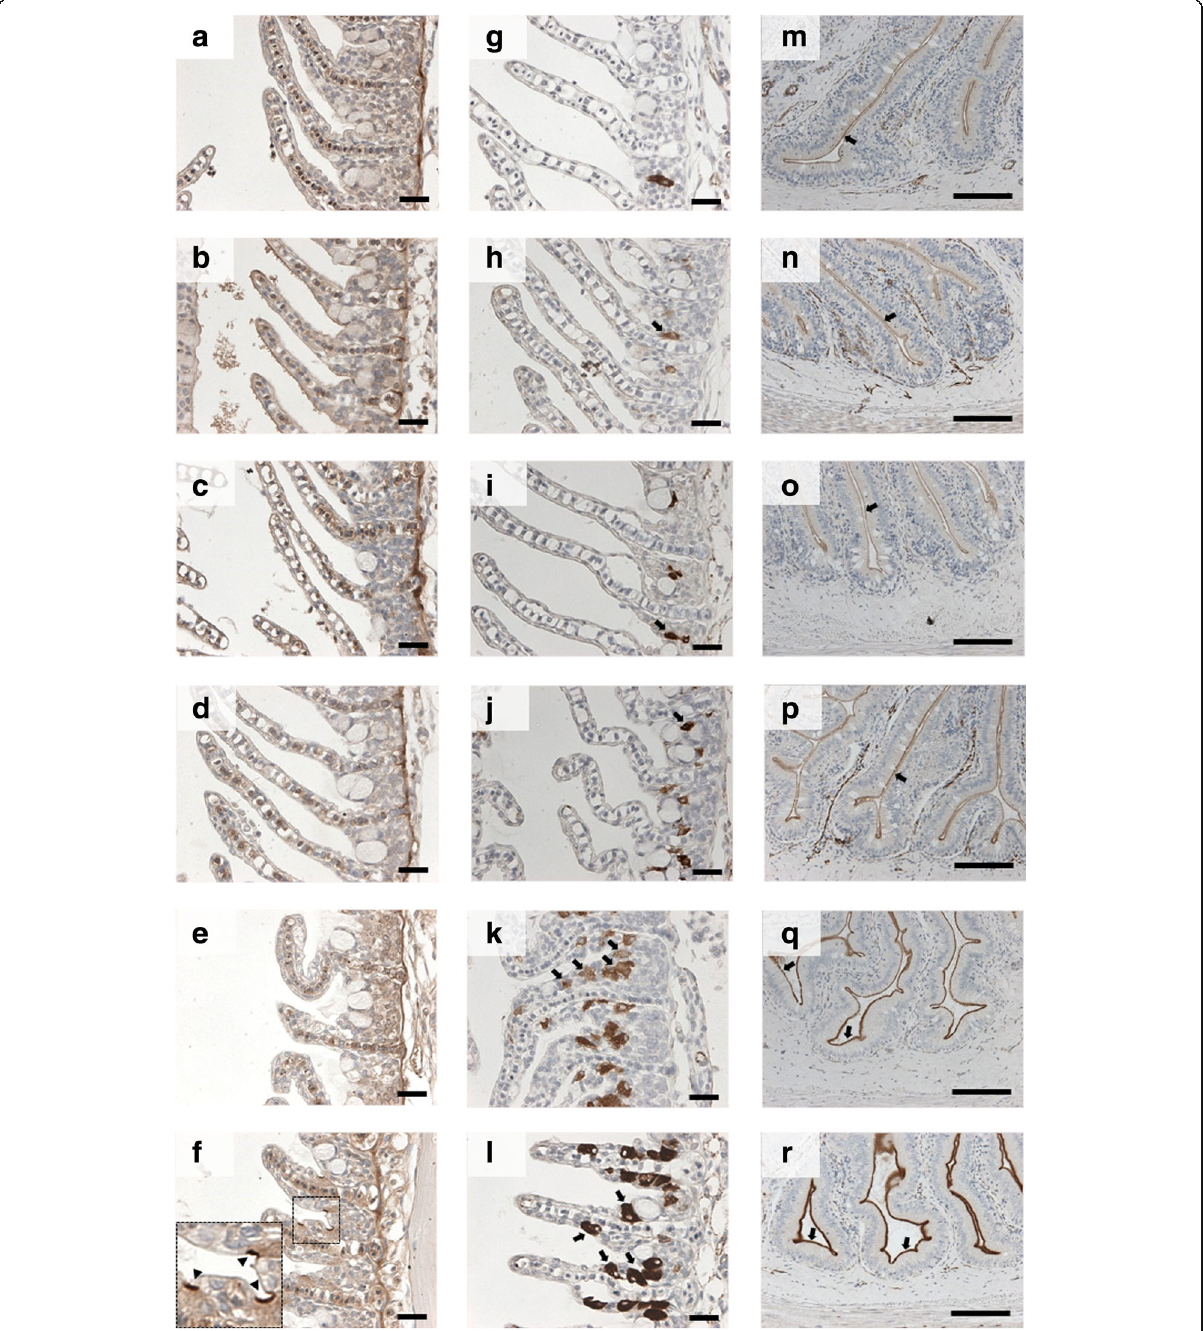
Fig. 2 Immunohistochemistry of NKCC and CFTR in the gill and anterior intestine (AI) of eels in FW and time course SW exposure. Apical CFTR signals (arrow heads) on the ionocytes at the interlamellar region are not observed from FW to SW 3 d ( a-e ), and become apparent on the ionocytes of SW 7 d eels ( f ). Basolateral NKCC (arrows) in ionocytes are scarcely observed from FW to SW 1 d ( g-j ), and become increasingly abundant in numbers and intensity from SW 3 d to 7 d ( k - l ). Apical NKCC (arrows) on the intestinal epithelia are present in all time course samples ( m - r ), but an increasing intensity is observed in SW 3 d to 7 d. Scale bar = 100 μ